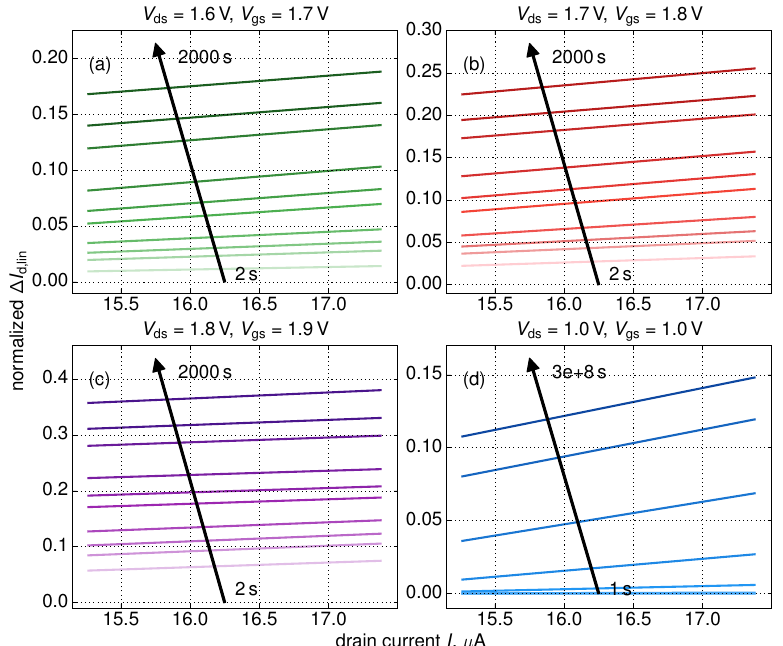
( 0 ) ) dependencies for all stress time steps and four combinations of V d,lin